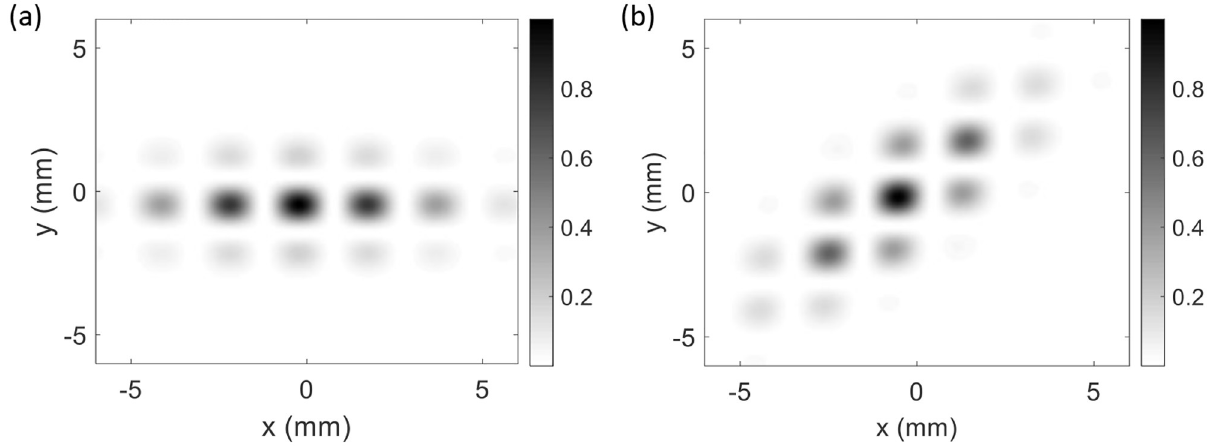
Fig 2. Patchy propagator model from Eq (4) with unit cell with a = 2 mm, spatial widths of δ x = 2.83 mm and δ y = 1 mm, and two OPs. (a) φ = 0˚, (b) φ = 45˚. The color bar shows the strength of connection from highest (black) to lowest (white).